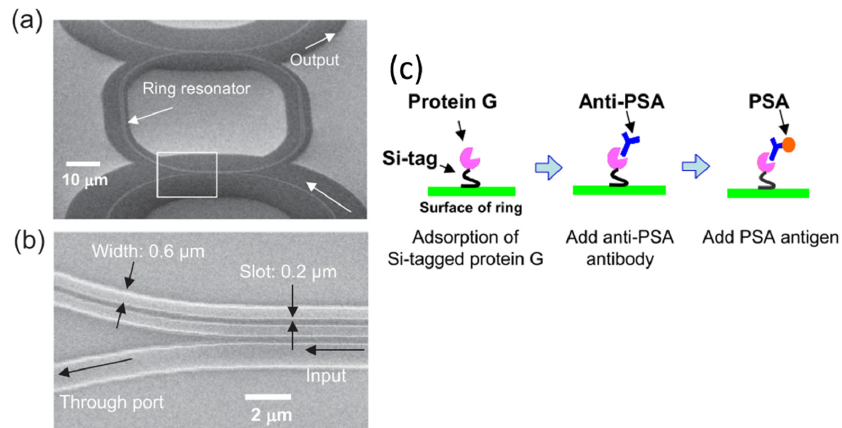
Figure 18. ( a ) Schematic of the CMRR setup. ( b , d ) SEM images of the grating used as couplers in different areas of the sensor, and ( c ) SEM of the reference ring coupled to the input waveguide. ( e ) Output power changes as a result of varying concentrations of progesterone (red), testosterone (black), and the NIP control (white), to demonstrate specificity. ( f ) Linear fit of power versus progesterone concentration. Reproduced from ref. [112] with permission © The Optical Society of America.